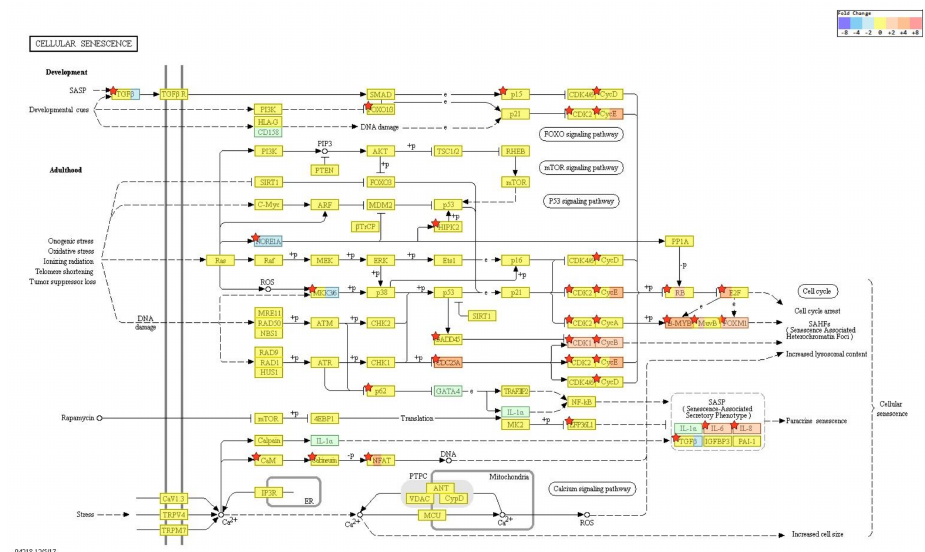
Figure 5. KEGG pathway analysis on cellular senescence. Among the cellular senescence genes, IL-6 and IL-8 expression were increased and TGF- β decreased in PM exposed cells ( p < 0.05). Pathway analysis for significant gene list were performed based on KEGG pathway (http://www.genome.jp/ kegg/pathway.html) (accessed on 19 July